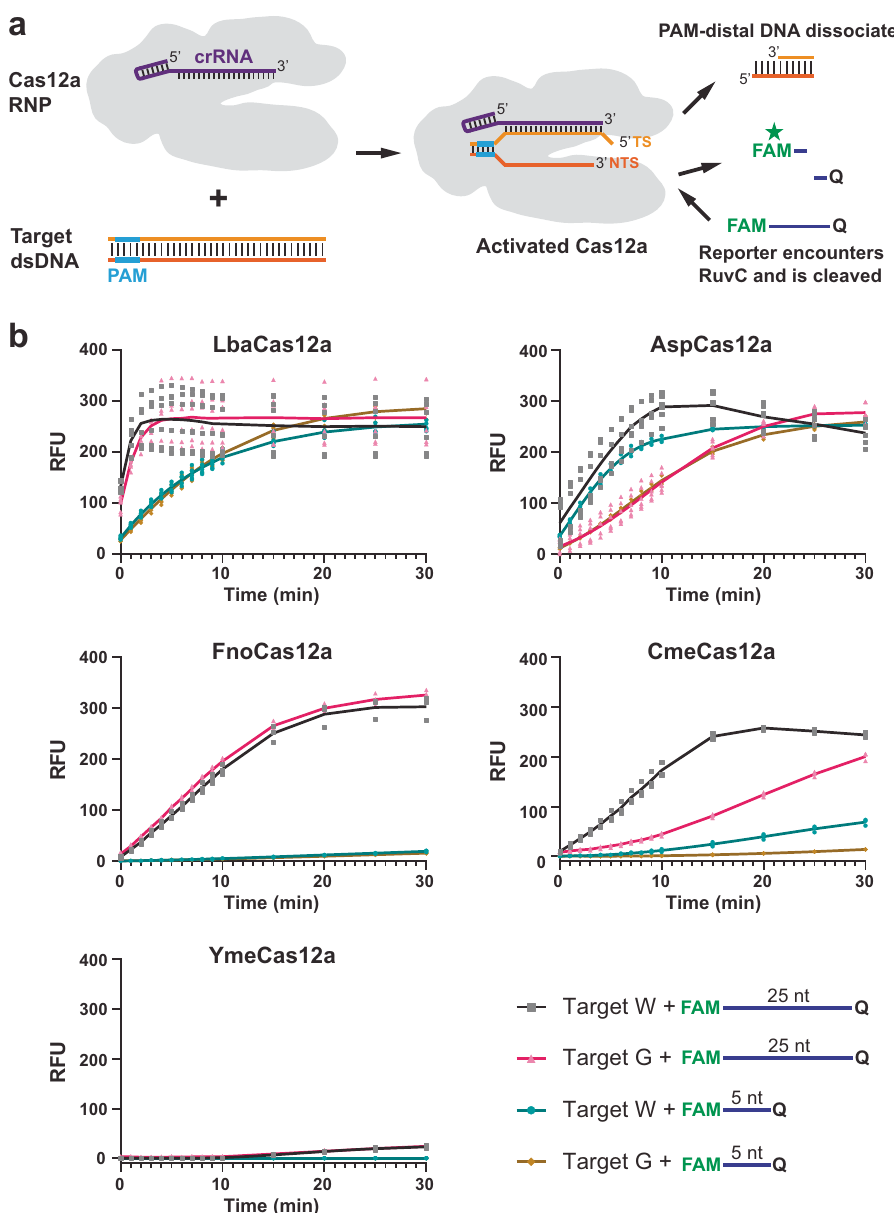
Fig. 6 Cas12a trans nuclease activity is in fl uenced by target sequence and reporter substrate length. a Schematic representation of Cas12a trans nuclease activity assays. Linear double-stranded DNA containing a TTTA PAM sequence fl anked by a target sequence is incubated with a complementary crRNA-Cas12a RNP at 37 °C to allow on-target cleavage. A reporter oligonucleotide with 5 ′ fl uorophore (FAM) and 3 ′ quencher (Q) modi fi cations is added and cleavage of the reporter via the trans nuclease activity of the activated Cas12a separates the fl uorophore and quencher resulting in increased fl uorescence. b Fluorescence was measured over time for a reporter that consisted of either a 25 nt de fi ned sequence DNA or 5 nt randomized sequence DNA. The mean relative fl uorescent unit (RFU) values for reactions with Target W DNA are plotted as black (25 nt reporter) or blue (5 nt reporter) lines. The mean RFU values for reactions with Target G DNA are plotted as magenta (25 nt reporter) or brown (5 nt reporter) lines. The RFU values represent background normalized signal derived by subtracting the fl uorescence of negative control reactions that did not contain target DNA. Individual data points for all experimental replicates are plotted on the graphs and the source data can be found in Supplementary Data